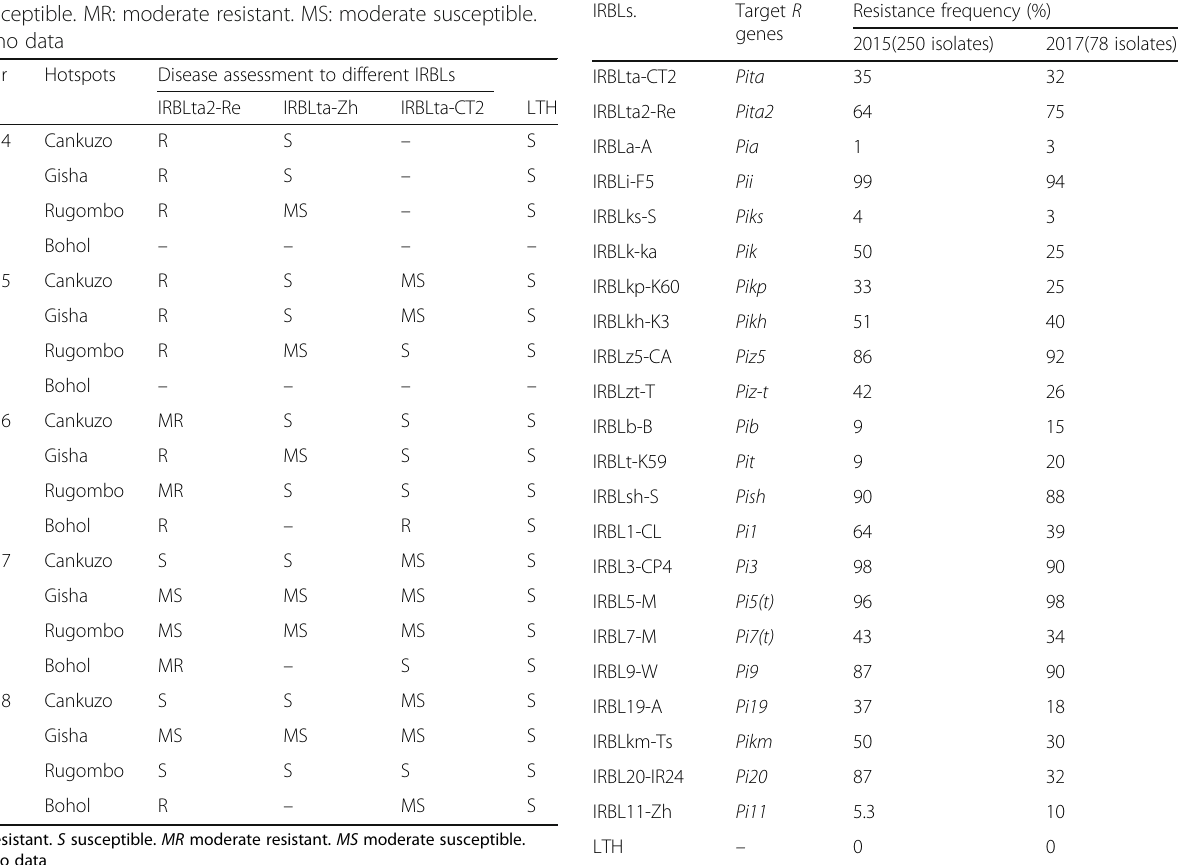
Table 1 Field resistance performance of Pita2 against rice blast population in the Philippines and Burundi. R: resistant. S: